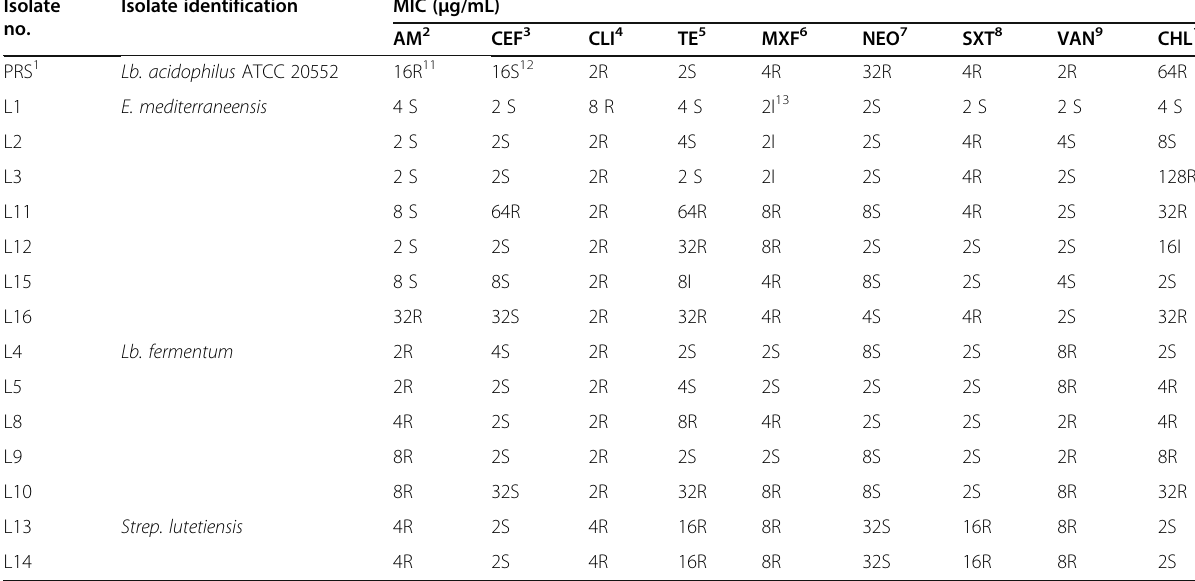
Table 3 Minimum inhibitory concentration ( μ g/mL) of 9 antibiotics against isolated LAB Isolate Isolate identification no.